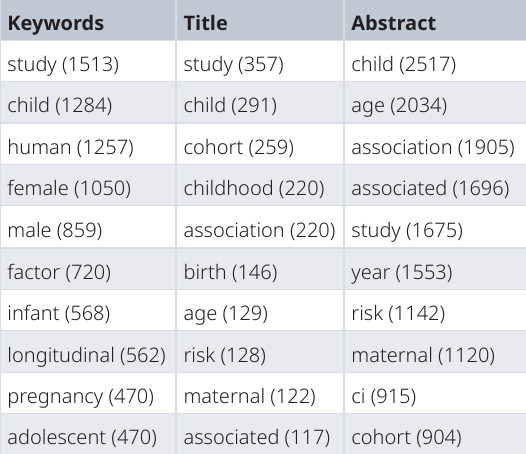
Table 5. Frequency of top ten lemmatized words used in keywords, titles and abstract text from the ALSPAC publications. The full list of words as output by the pipeline is available in the output data (see data availability). The numbers in parentheses are the count.